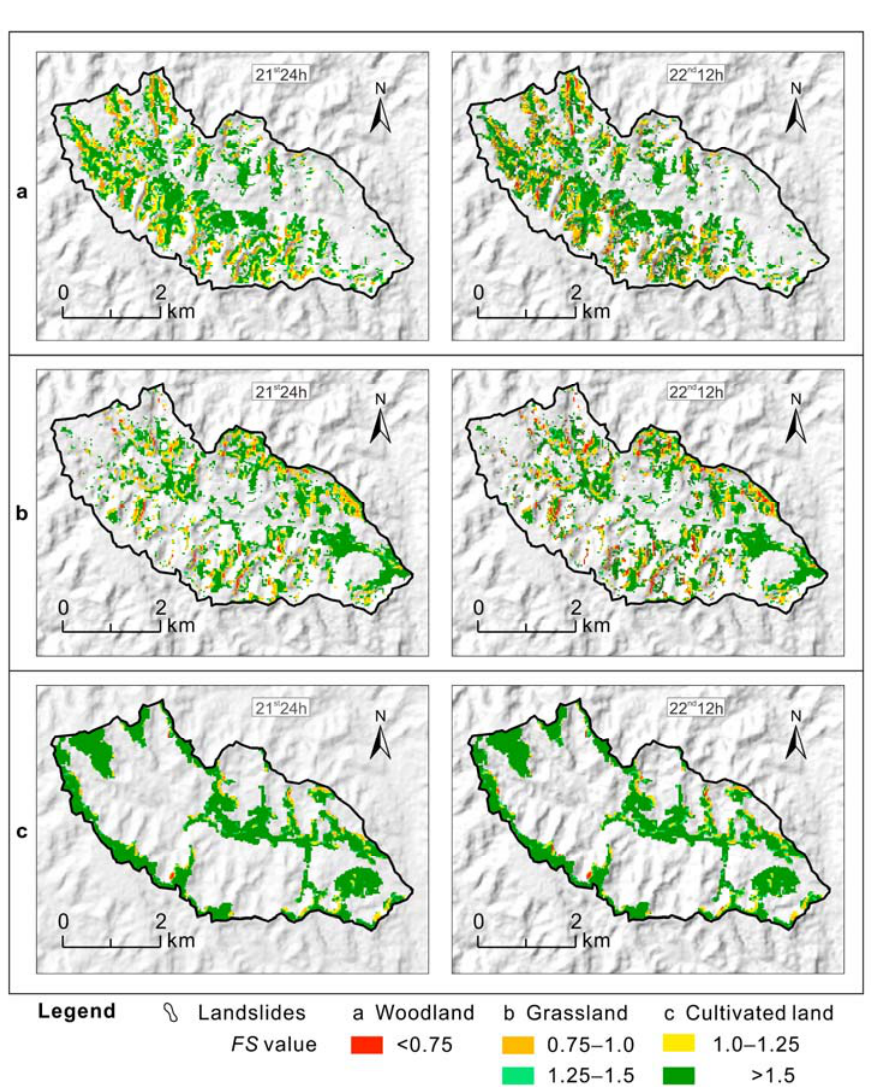
Figure 7. Slope stability conditions, expressed in terms of the factor of safety ( FS ), and landslide potential maps of the slopes obtained from the TRIGRS simulation for the different types of vegetation cover (the grey base map represents the